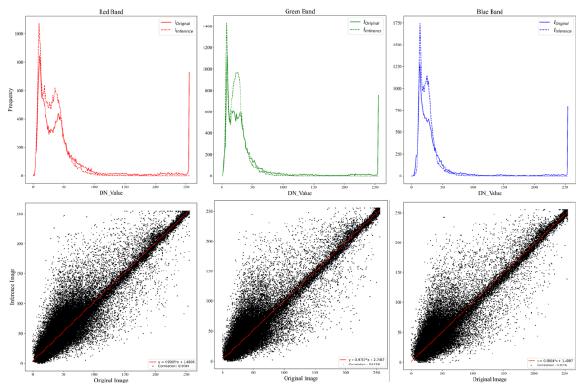
Figure 16 . Comparison of histograms (top) and scatterplots (bottom) between ground truth and model generated image of a selected test data tile from EXP1.